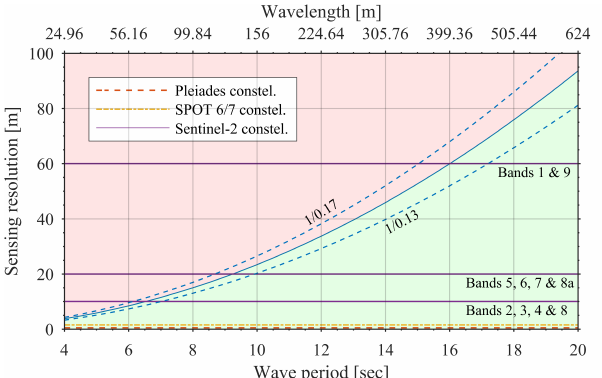
Figure 11. Sensing resolution as a function of wave period/length. The solid blue line represents the resolution’s limit to resolve an associated deep-water wave period/length. The green area indicates sufficient resolution while the opposite is true for the red area. The purple lines (Sentinel-2 constellation) are plotted for bands 1 to 9 with 10, 20 and 60 m